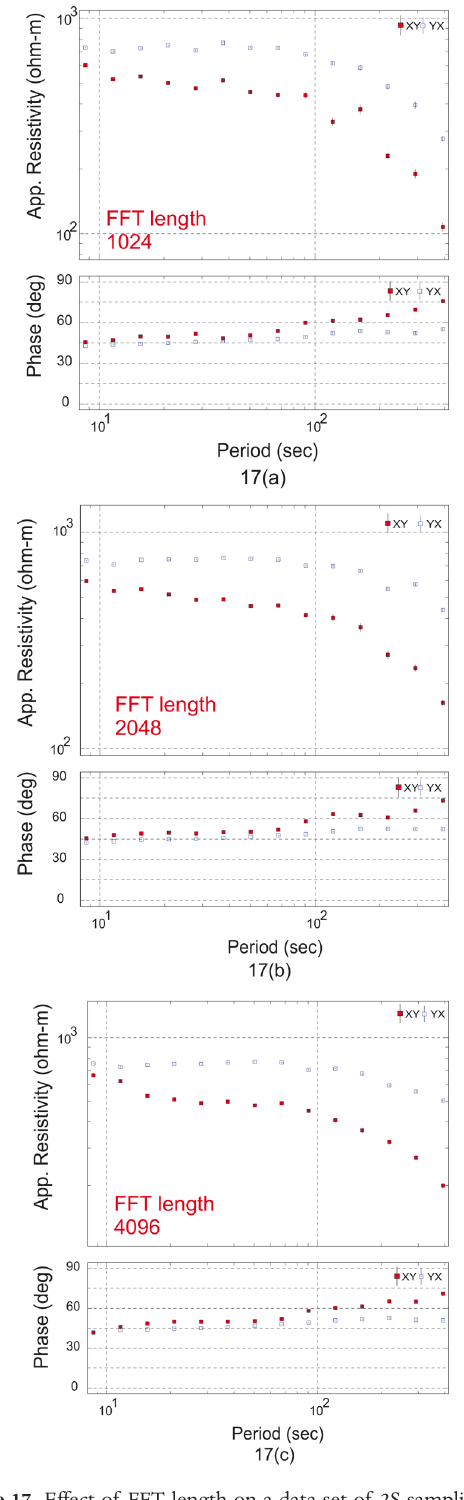
Figure 17. Effect of FFT length on a data set of 2S sampling fre- quency of noise free remote site A28 with 659,399 data points. (a) Apparent resistivity (upper panel) and phase (lower panel) curves obtained from the data using a FFT length of 1024. (b) Apparent re- sistivity (top panel) and phase (bottom panel) curves obtained ap- plying a FFT length of 2048 on the same data set. (c) Apparent resistivity (top panel) and phase (bottom panel) curves obtained ap- plying a FFT length of 4096. As this data is free from random noise so during stacking only signals get stacked and so all the FFT lengths provide almost similar outcome. The red colored boxes represent XY components and the blue colored boxes represent YX compo- nents of apparent resistivity and